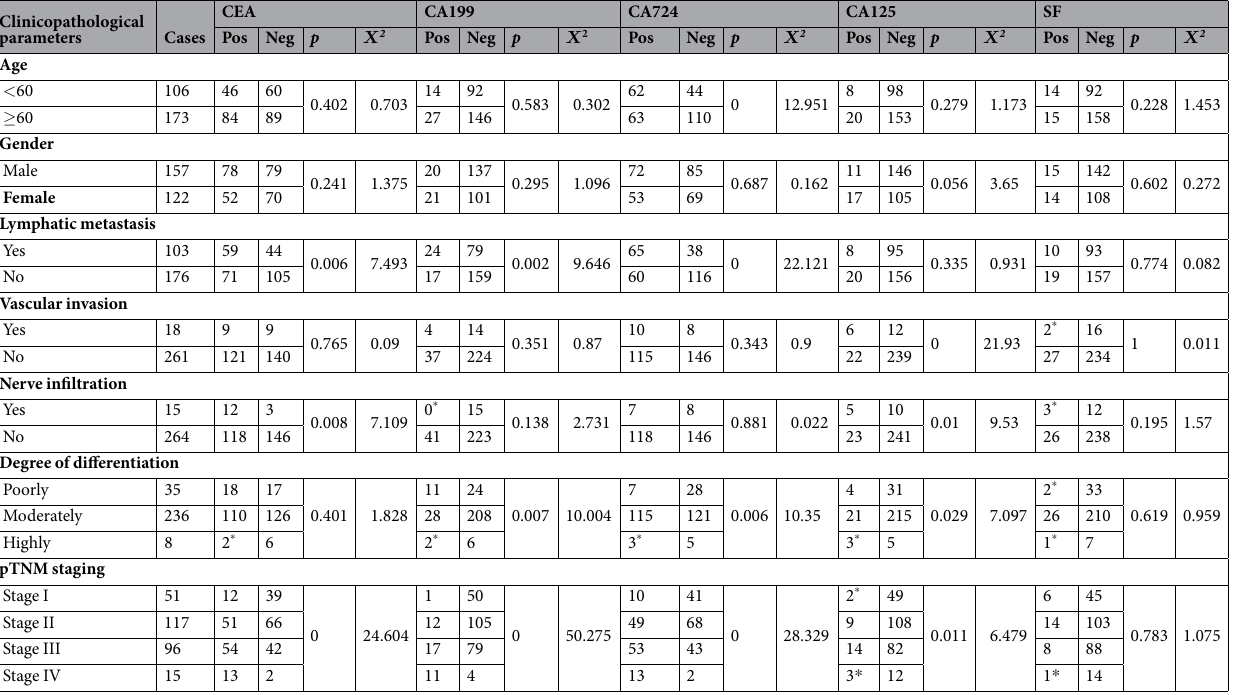
Table 2. The relationship of biomarkers and clinicopathological parameters of CRC. * Indicates that the theoretical frequency of the four-cell table is less than 5, and the statistical analysis was performed using Fisher exact probability method. Pos: Positive; Neg: